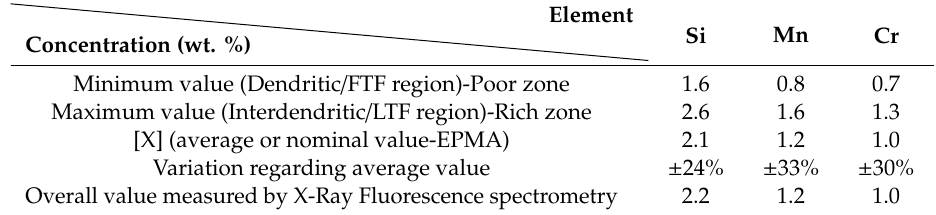
Table 2. Maximum and minimum concentration values (wt. %) of each element obtained from EPMA maps. Element Si Mn Cr Concentration (wt. %) Minimum value (Dendritic / FTF region)-Poor zone Maximum value (Interdendritic / LTF region)-Rich zone Variation regarding average value ± 24% Overall value measured by X-Ray Fluorescence